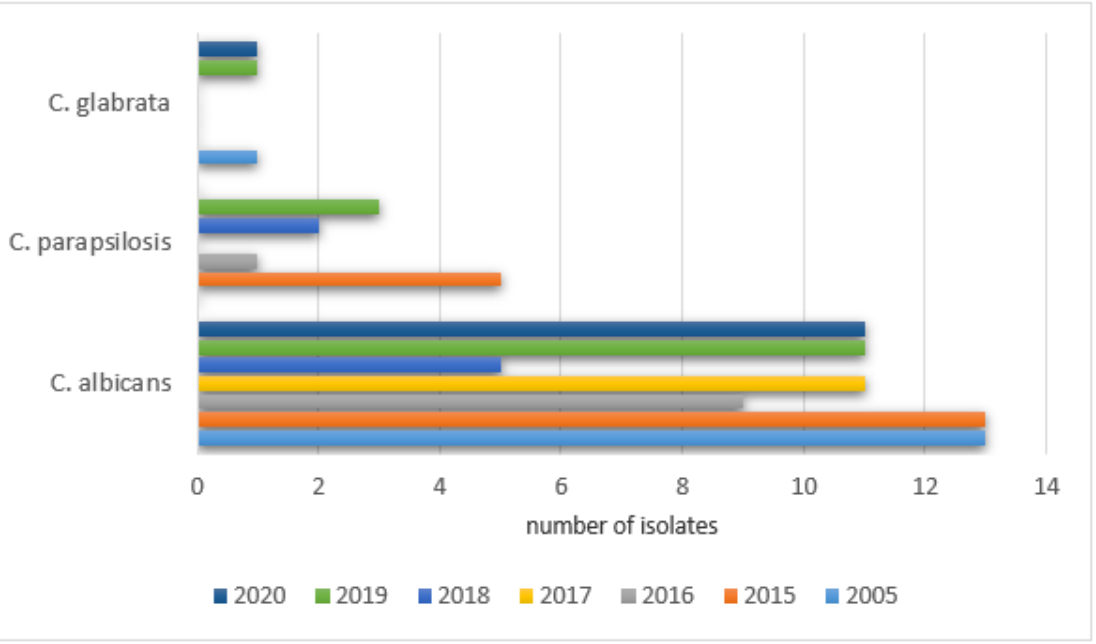
Figure 10. Yeast species isolated from gastrointestinal tract NICU samples in the studied years.